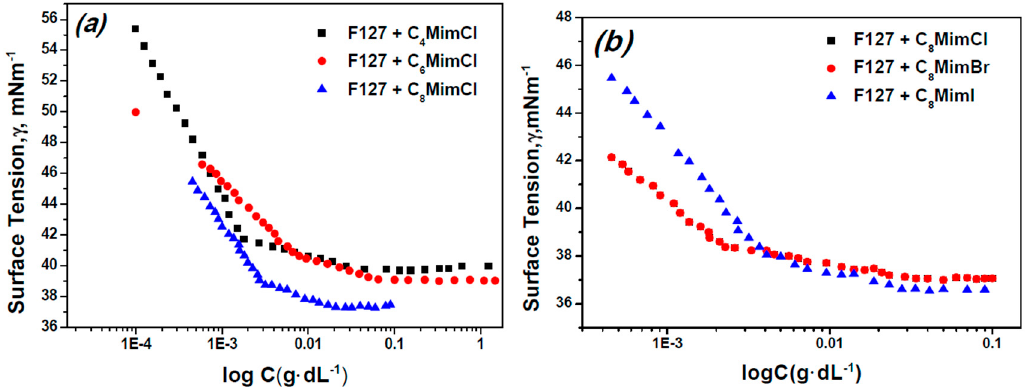
Figure 2. Surface tension behavior of F127 in presence of various IL. ( a ) Effect of chain length and ( b ) effect of